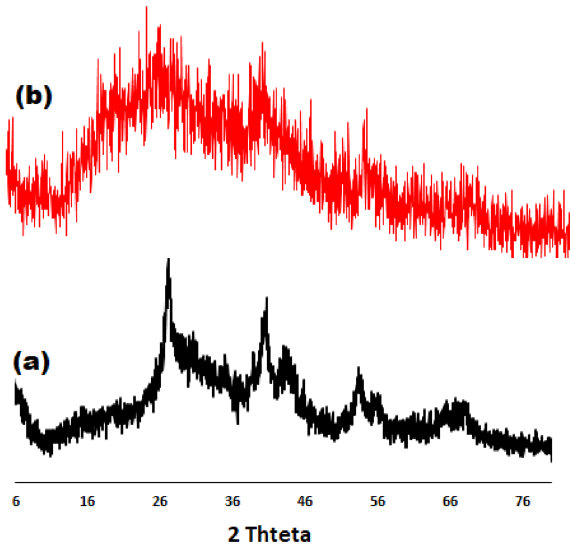
Figure 3. XRD patterns of Mg–Al LDH ( a ) and LDH–APS–PEI–DTPA nanocomposite ( b